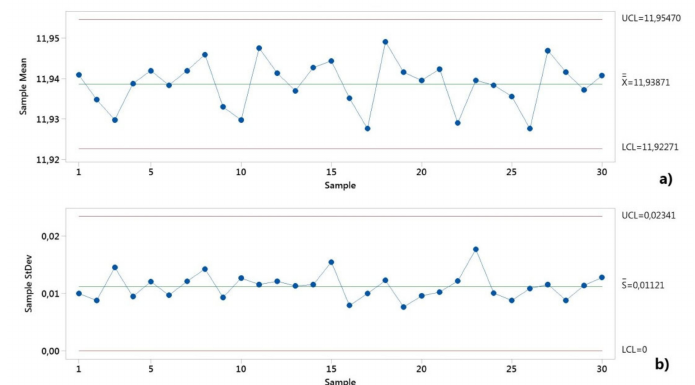
Figure 10. The control charts for the long-term capability study of height dimension (H): ( a ) mean data; ( b ) standard deviation data.